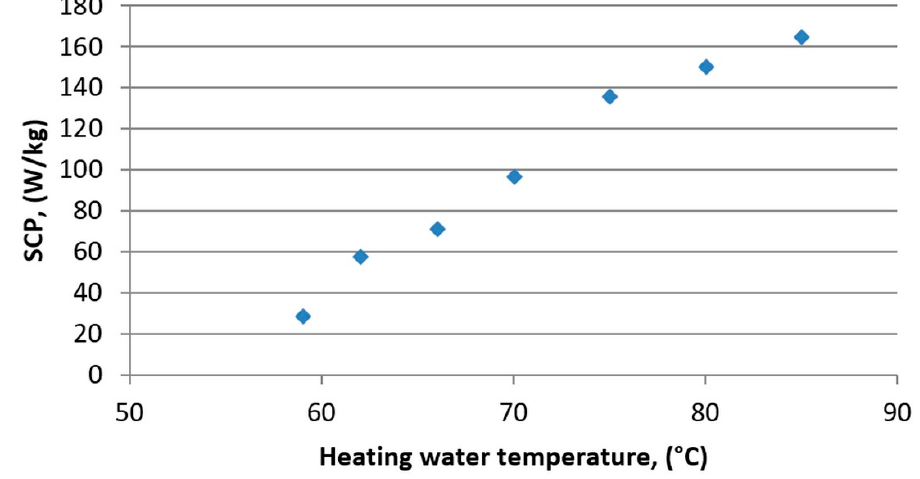
Figure 4. The influence of the heating water temperature on the specific cooling power (SCP).